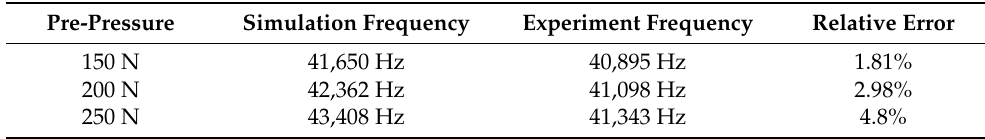
Figure 15. The influence of different pre-pressures on the motor speed. Table 3. Comparison of simulation results and experimental results.